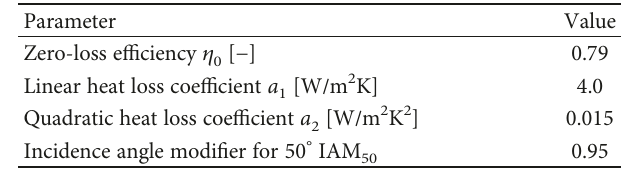
Table 4: Main parameters of solar photothermal collectors used in analysis.